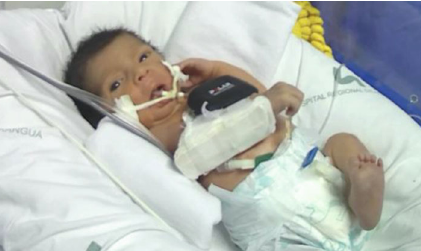
Figure 1: Illustration about the newborn using the heart rate